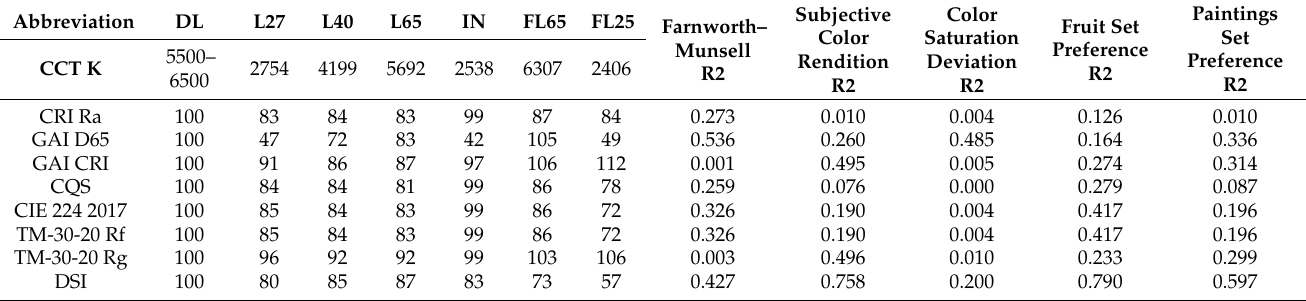
Table 3. Color rendition and coefficient of determination for color discrimination, subjective color rendition and color preference of the current metrics according to the studied light sources and